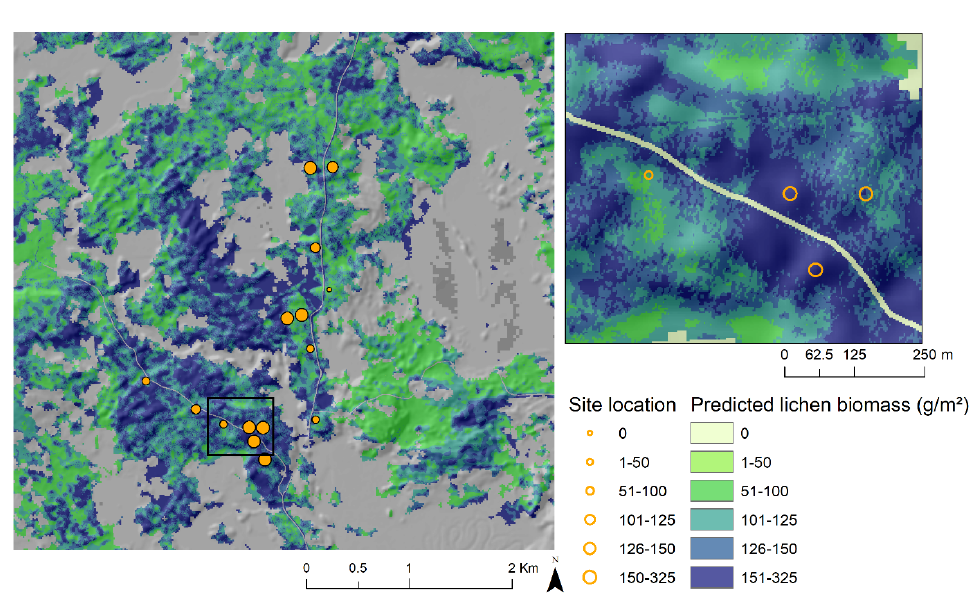
Figure 5. Predicted lichen biomass (g / m 2 ) for an area of central Alberta, Canada using spectral band data and ALS-derived canopy cover ( > 1.37 m height). Plot locations are marked in orange, and are scaled by lichen abundance. Larger circles represent plots where lichen biomass was measured between 151 and 325 g / m 2 . Riparian zones and roads were masked from the map.